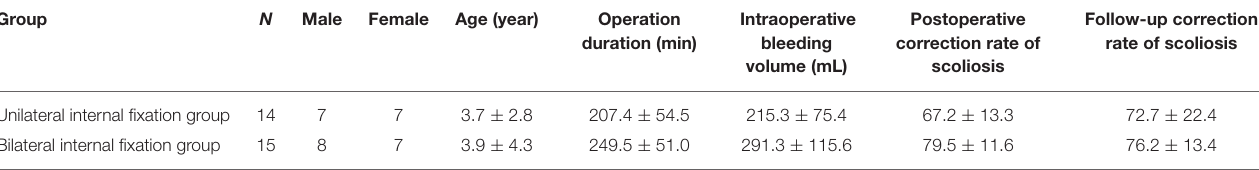
Follow-up correction Postoperative rate of scoliosis correction rate of scoliosis volume (mL)